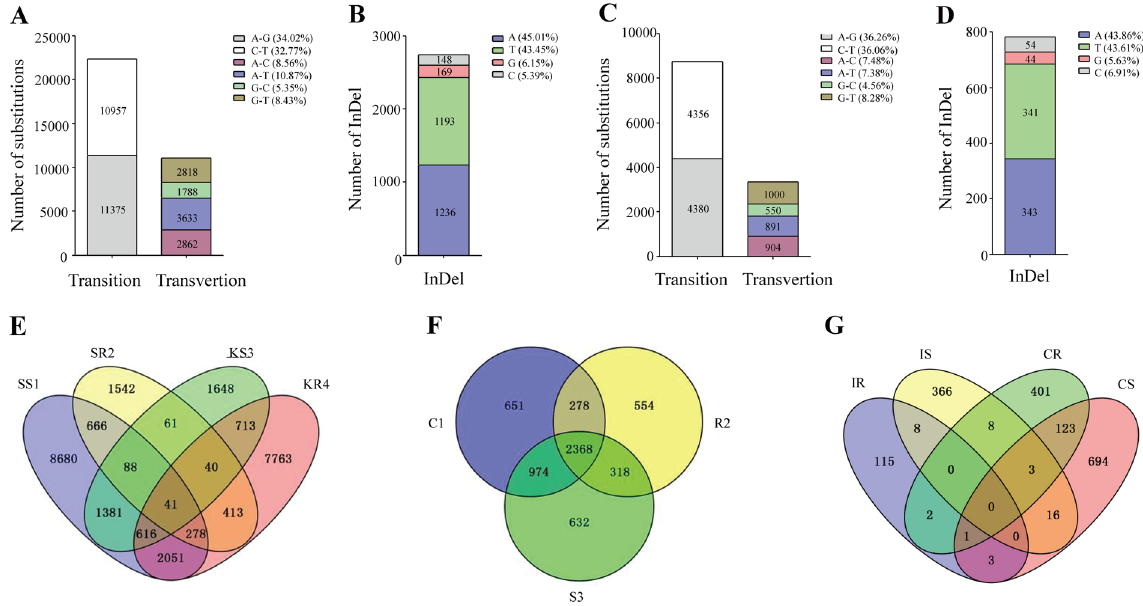
Figure 1. Statistical analyses and venn diagrams of SNPs, InDels and genes based on transcriptome datasets. ( A ) and ( B ) represent the substitutions and InDels in individuals, respectively. ( C ) and ( D ) represent the substitutions and InDels in cell lines, respectively. ( E ) Venn diagram describes the overlapped resistance/ susceptibility-associated SNPs among SS1, SR2, KS3 and KR4 in individuals. ( F ) C1 represents SNPs from the transcriptome of control CIK cells, and R2 and S3 stands for SNPs in resistant and susceptible cell lines, respectively. ( G ) IR and IS represent genes containing resistance/susceptibility-associated SNPs in individual transcriptomes, respectively, CR and CS stand for genes containing resistance/susceptibility-associated SNPs in cell transcriptomes,